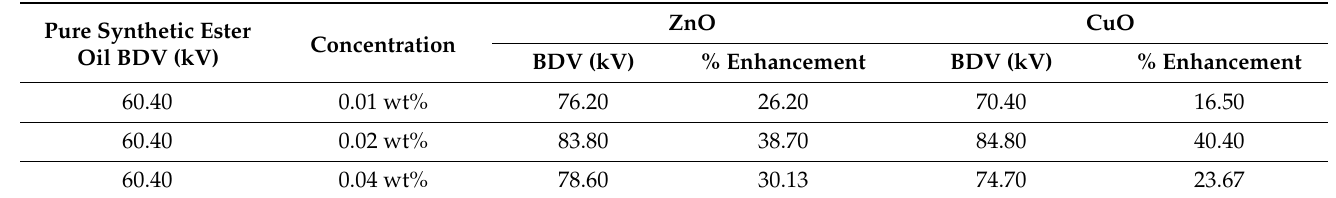
Table 4. Enhancement in AC Breakdown Voltage for Pure SE oil and Nanofluids.